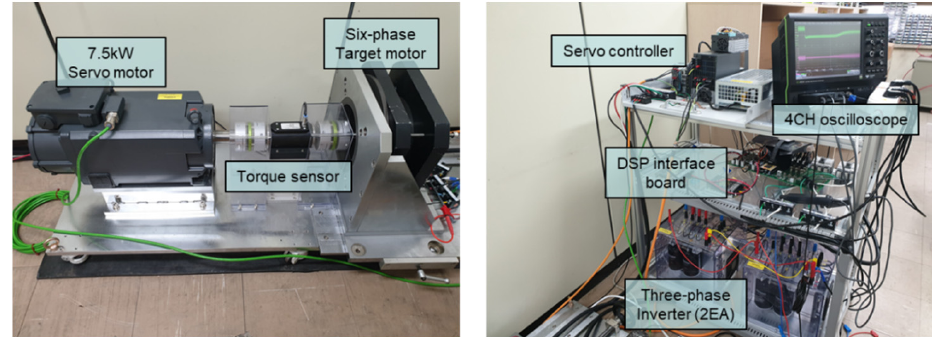
Figure 11. Experimental setup for testing.